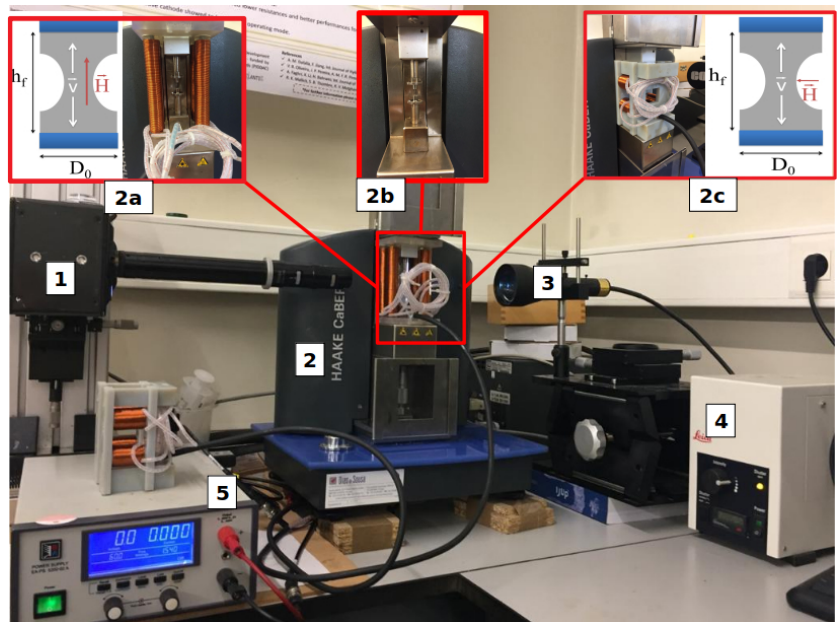
Figure 3. Experimental setup: ( 1 ) High-speed camera; ( 2 ) CaBER device: ( 2a ) ExMRFx with parallel configuration, ( 2b ) non-magnetic field, and ( 2c ) ExMRFx with perpendicular configuration; ( 3 ) Telecentric Backlight Illuminator; ( 4 ) light source; ( 5 ) DC power